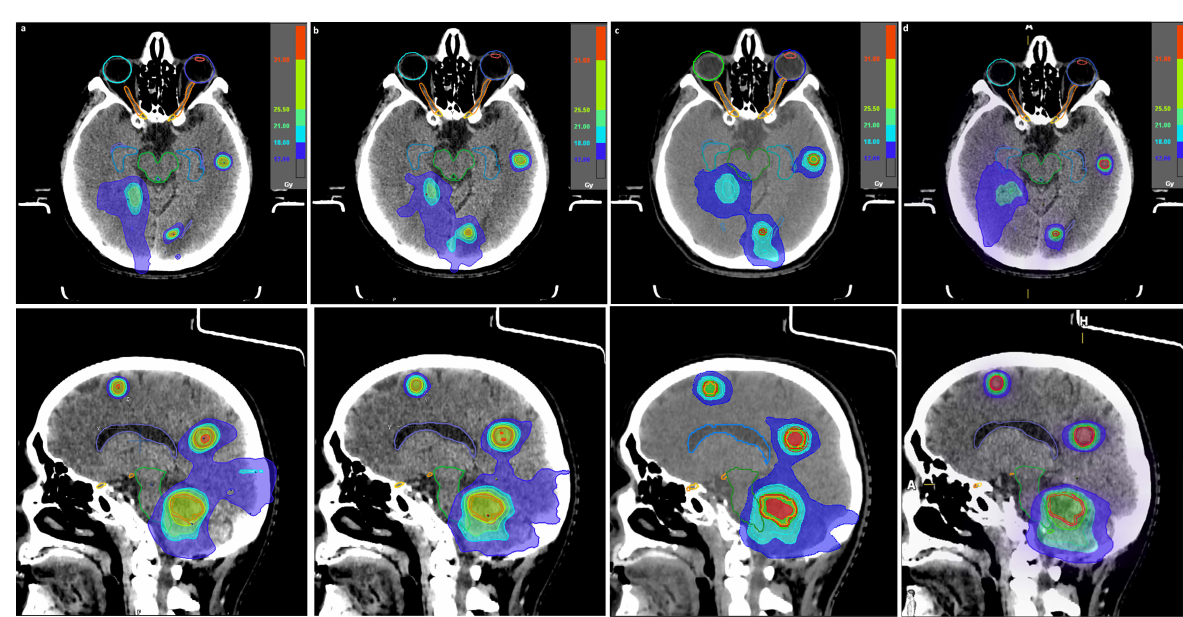
Figure 1. Dose distribution in axial (top) and sagittal (bottom) plane of patient 9 for separate-isocenter dynamic conformal arc (DCA) ( a ), intensity modulated radiotherapy (IMRT) ( b ), volumetric modulated arc radiotherapy (VMAT) ( c ), and Multiple Brain Mets SRS Elements (MBM Elements) v.2.0 with high normal tissue (NT) ( d ) plans. From the four MBM Elements plans, only the plan with the lowest gradient index is presented as representative from those